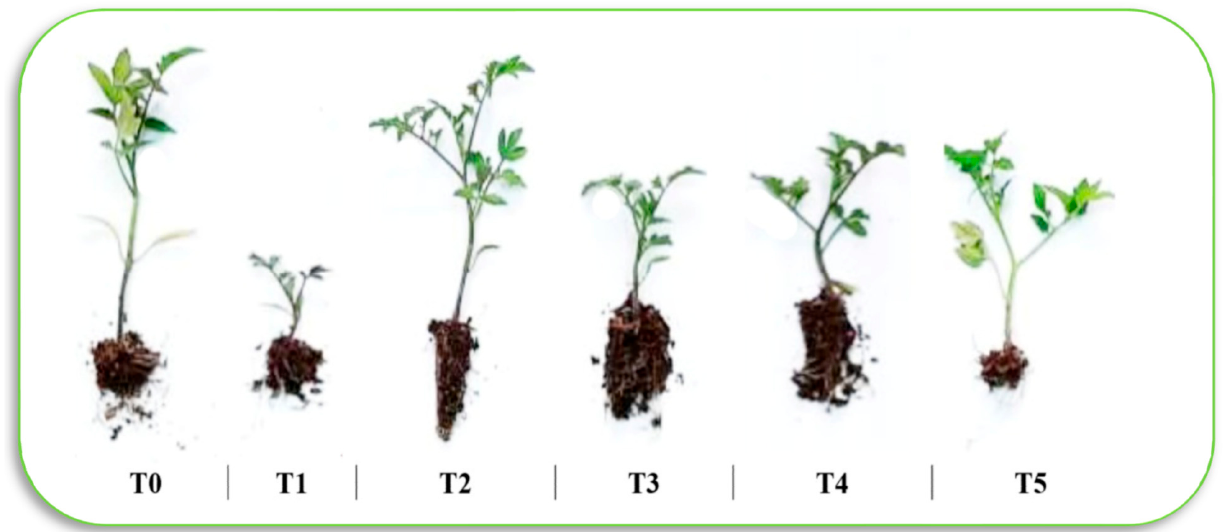
Figure 6. An overview of the tomato seedlings after 30 days from infection with Rhizoctonia solani under applying the treatments (PBZ and Trichoderma ), compared to the applying recommended fungicide under greenhouse conditions. For more details concerning the treatments T0, T1, T2, T3, T4, and T5, please refer to Table 1. Table 6. Effect of treatments on pre-, and post-emergence, survival plants and disease severity per- cent of tomato seedlings that infected with R. solani compared to control or healthy plants.